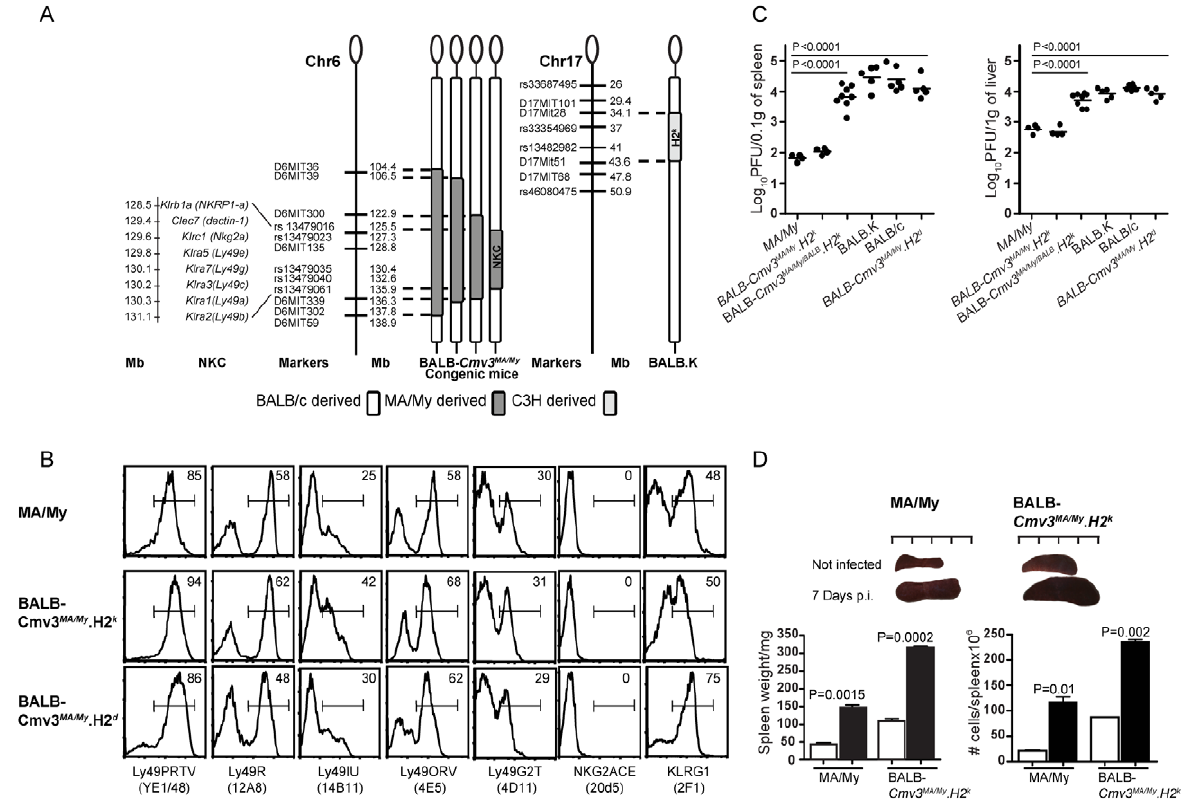
Figure 1. Generation, phenotype, and MCMV infection outcome of BALB mice congenic for the natural killer gene complex inherited from MA/My mice. (A) Left, physical map of chromosome 6 markers used to determine the size of the MA/My fragment introgressed into the BALB background. The four versions of chromosome 6 indicate the genotypes of sub-congenic strains produced during the generation of BALB. Cmv3 MA /My congenic mice carrying a 10 Mb segment (between SNPs rs13479016 and rs13479061 ) spanning the NKC region from parental MA/My mice. Right, physical map of chromosome 17 markers used to characterize the 9.4 Mb segment (between D17Mit28 and D17Mit51 ) comprising the H2 region of BALB.K mice ( H2 k ). (B) NK cell receptor expression in MA/My parental mice and derived BALB- Cmv3 MA/My H2 d and BALB- Cmv3 MA/My H2 k congenic mice. The receptors (indicated on the bottom of the panel) were gated by FACS on NKp46 + splenic NK cells; the proportion of expression is indicated in each histogram. (C) Viral load in spleens (left) and livers (right) of mice of the indicated genotypes, as determined by plaque-forming assays 3 days p.i. (D) Spleen size (top) and weight and total cellularity (bottom) determined in MA/My and BALB- Cmv3 MA/My H2 k mice at 7 days p.i. White bar, uninfected mice; black bar, MCMV-infected mice. Data were analyzed using two-way ANOVA analysis and the two-tailed Student’s test. Data are presented as mean 6 SEM and P values of significant differences between groups are indicated. Results shown in panel B are representative of three experiments using 2–3 mice per group; results shown in panels C and D are representative of five independent experiments using 3–8 mice per group.